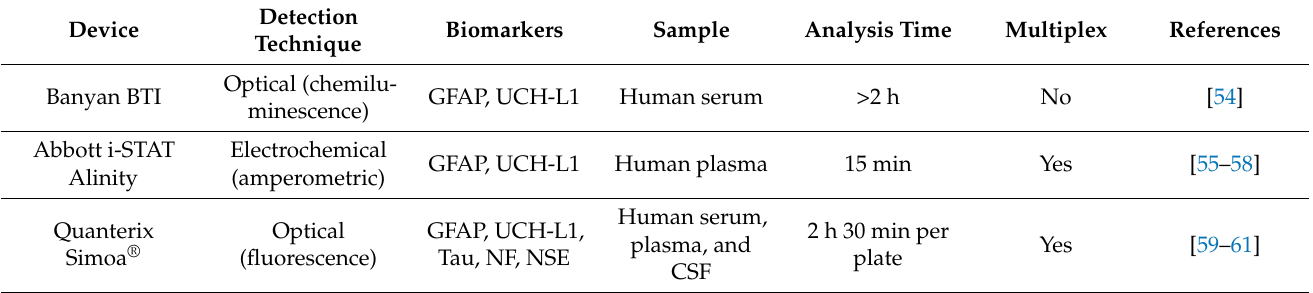
Table 2. Summary of the features of current late-stage sensors for measuring TBI